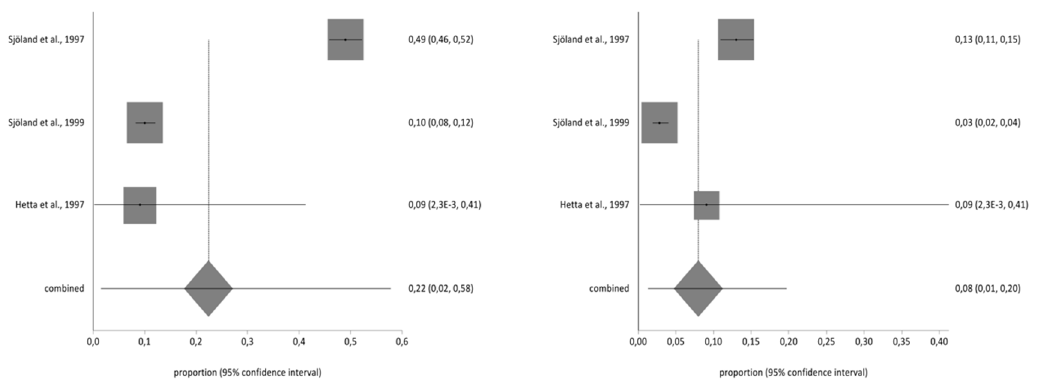
Figure 8. Pre- and post-impact on holidays.